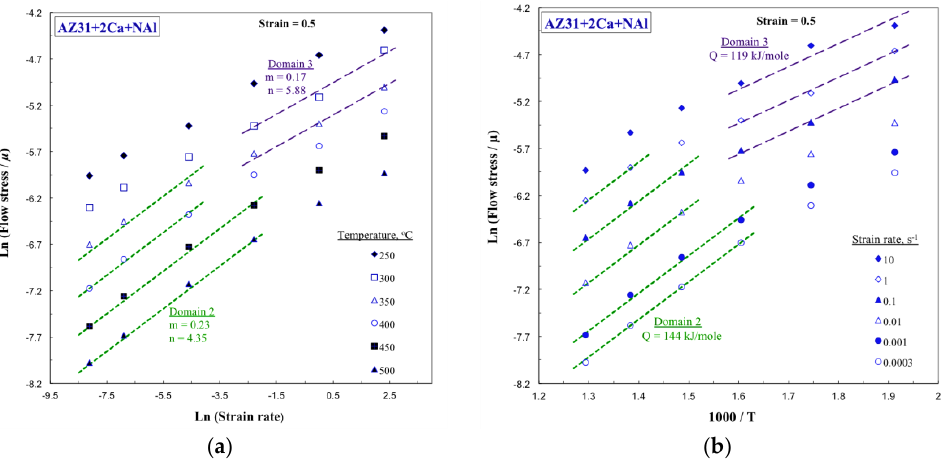
Figure 8. ( a ) Variation of normalized flow stress with strain rate on natural logarithmic scale, and ( b ) Arrhenius plot of normalized flow stress with inverse of absolute temperature. The apparent activation parameters n and Q are estimated with data relevant to various domains of processing map for the AZ31-2Ca-1.5NAl composite.